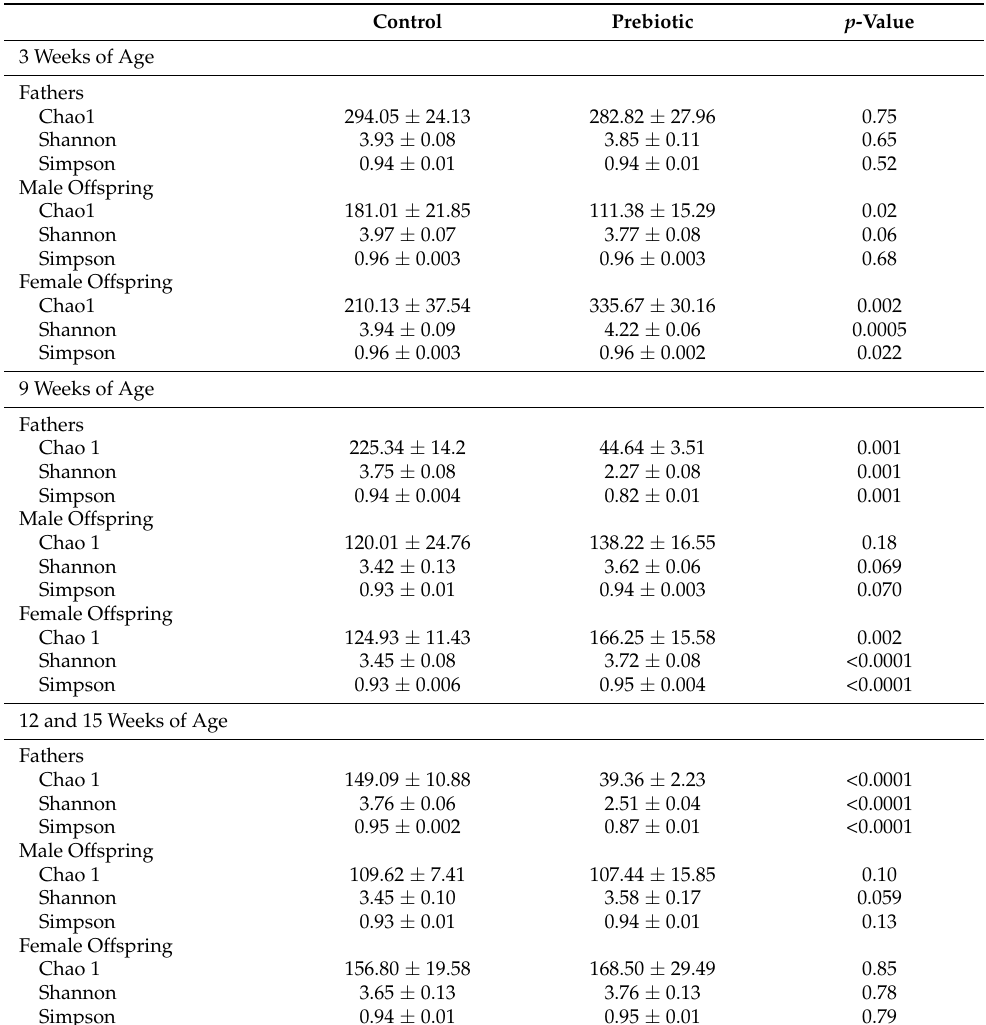
Table 4. Alpha diversity at three different age groups in fathers and offspring 1